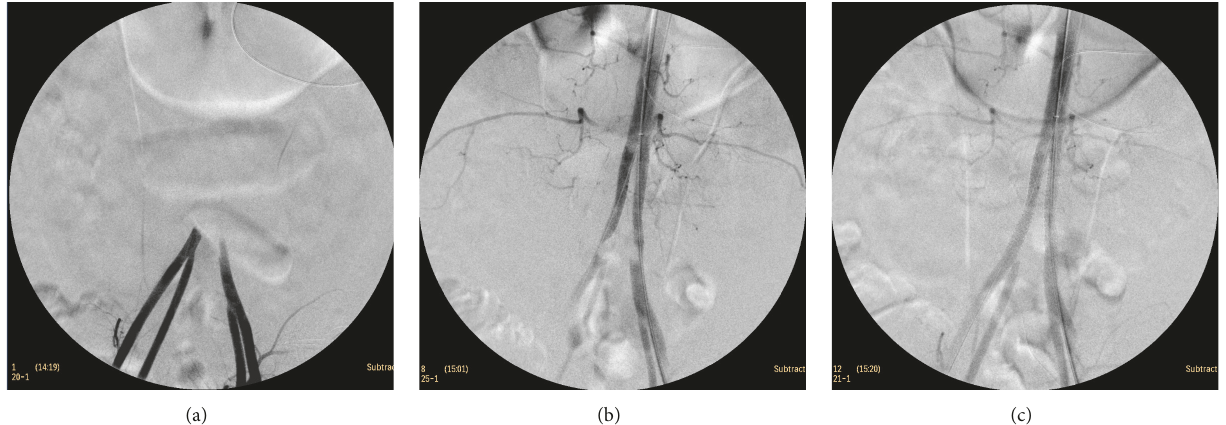
Figure 3: Intraoperative DSA revealed occlusion of aortoiliac bifurcation. Final angiography after deployment of balloon expandable covered stents with excellent runoff without any residual stenosis.